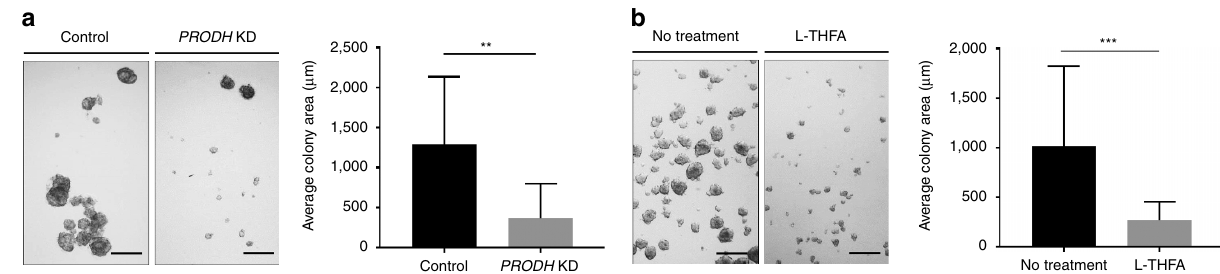
Figure 2 | Proline catabolism via Prodh supports 3D growth. ( a ) Representative pictures and size quantification of MCF10A H-Ras V12 spheroids transduced with an inducible lentiviral CRISPR with or without guide for PRODH . CRISPR expression was induced with 0.1 m gml (cid:2) 1 doxycycline. Analysis was performed 5 days after PRODH knockdown (KD) induction. ( b ) Representative pictures and size quantification of MCF10A H-Ras V12 spheroids with or without L-THFA treatment. Treatment was started at day 0. Analysis was performed at day 5 of treatment. Scale bar: 150 m m. The number of